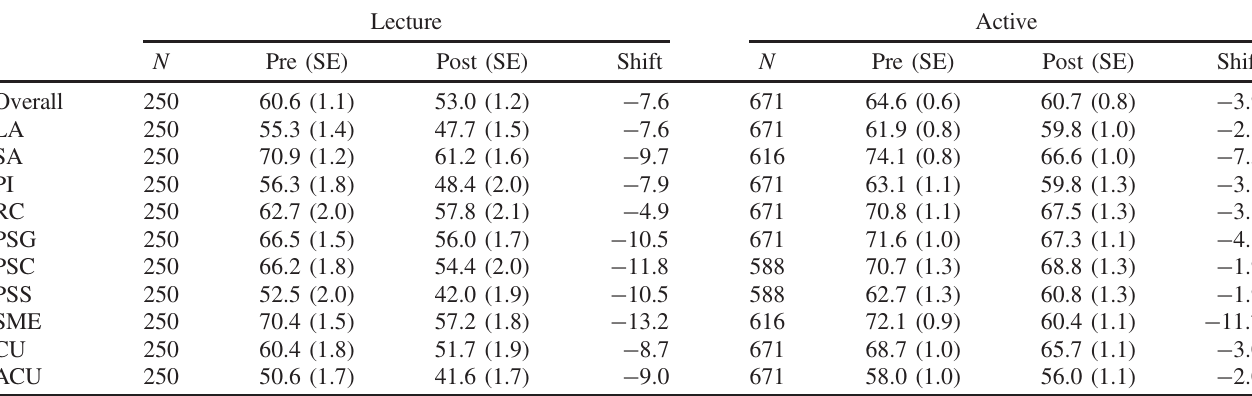
TABLE IX. Detailed descriptive statistics for the whole-year CLASS. SE indicates Standard error.